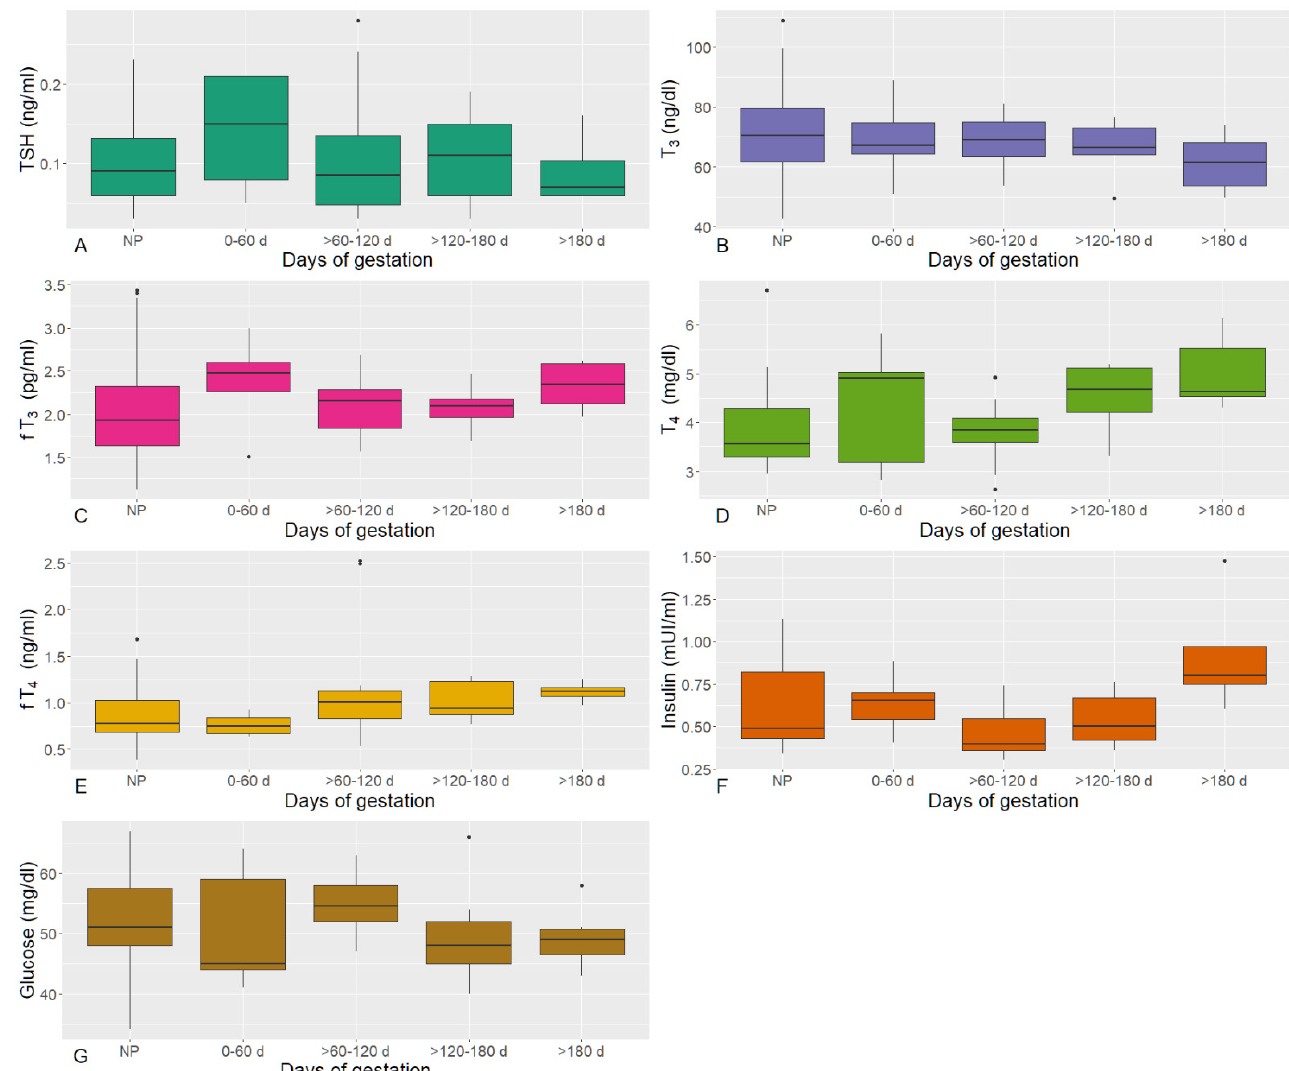
Figure 1. Boxplots of circulating thyroid ‐ stimulating hormone (TSH, A ), total triiodothyronine (T 3 , B ), free triiodothyronine (fT 3 , C ), total thyroxine (T 4 , D ), free thyroxine (fT 4 , E ), insulin ( F ), and glucose ( G ) in pregnant and nonpregnant (NP) cows.